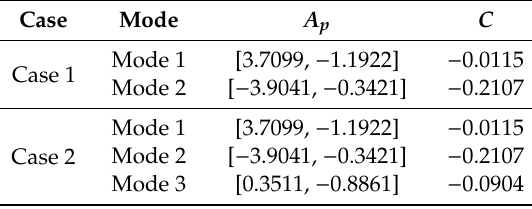
Table 1. The true values of the simplified model parameters of case 1 and 2.